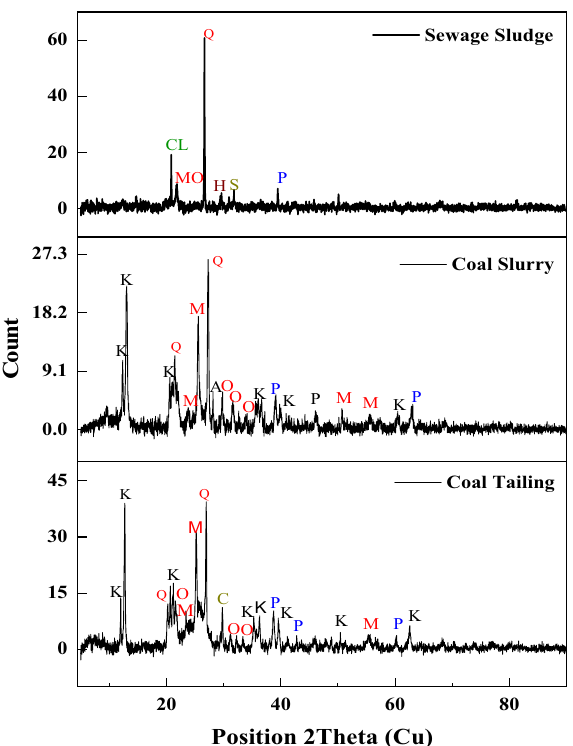
Figure 3. Raw samples XRD pattern. Clay Mineral phases; K (Kaolinite); Silicate mineral; M (Muscovite), AN (Anorthite), Q (Quartz), MO (Moganite), O(Orthoclase) Oxide mineral; H (Hematite), Sulphur mineral; P (Pyrite), Carbonate mineral; S (Siderite), C (Calcite); Chlorite mineral; CL